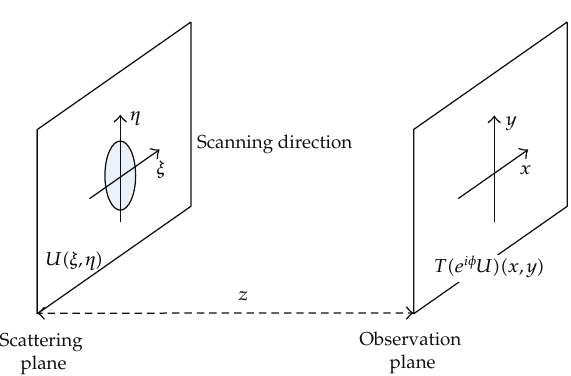
Figure 3: Free-space propagation model of scattered light. U (cid:3) ξ,η (cid:4) is the incident optical field in the scattering plane, and T (cid:3) e iφ U (cid:4)(cid:3) x,y (cid:4) is the optical field of the interference pattern in the observation plane.